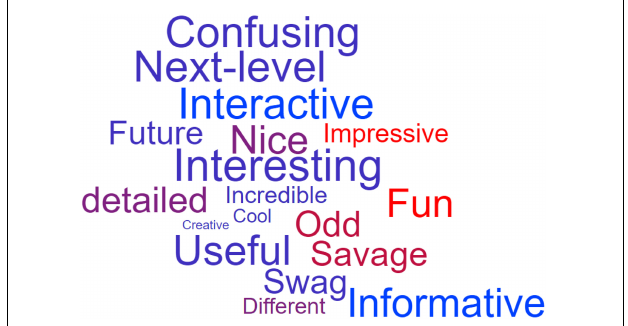
FIGURE 12 | Children’s feelings on using data in the elementary classroom that has been collected from an IoT based environment monitoring system.